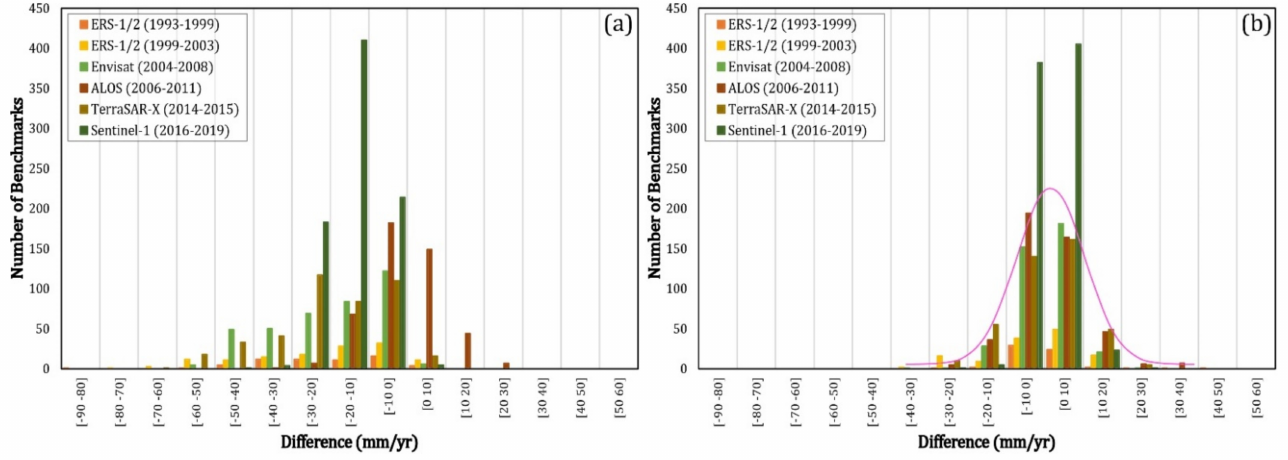
Figure 3. Histograms of the differences between the vertical velocities from leveling and InSAR ( a ) before and ( b ) after the InSAR calibration (Section 3.2), at an interval of 10